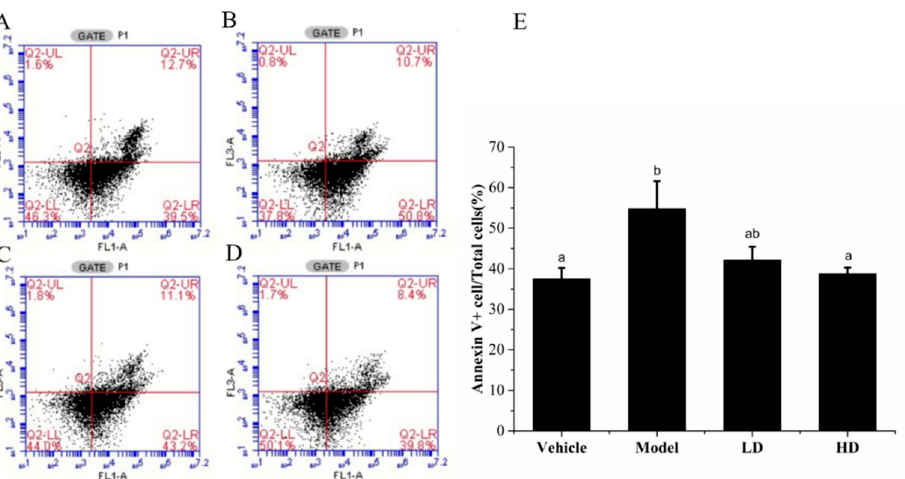
Figure 5. RAW264.7 cells were stained with annexin V-FITC and propidium iodide (PI) as detected by flow cytometer. ( A ) Vehicle group. ( B ) Model group. ( C ) LD group. ( D ) HD group. Statistical analysis was performed using a one-way ANOVA with Tukey’s test. Data represent the mean ± SD ( n = 6). Different letters represent significant differences between groups ( p < 0.05).